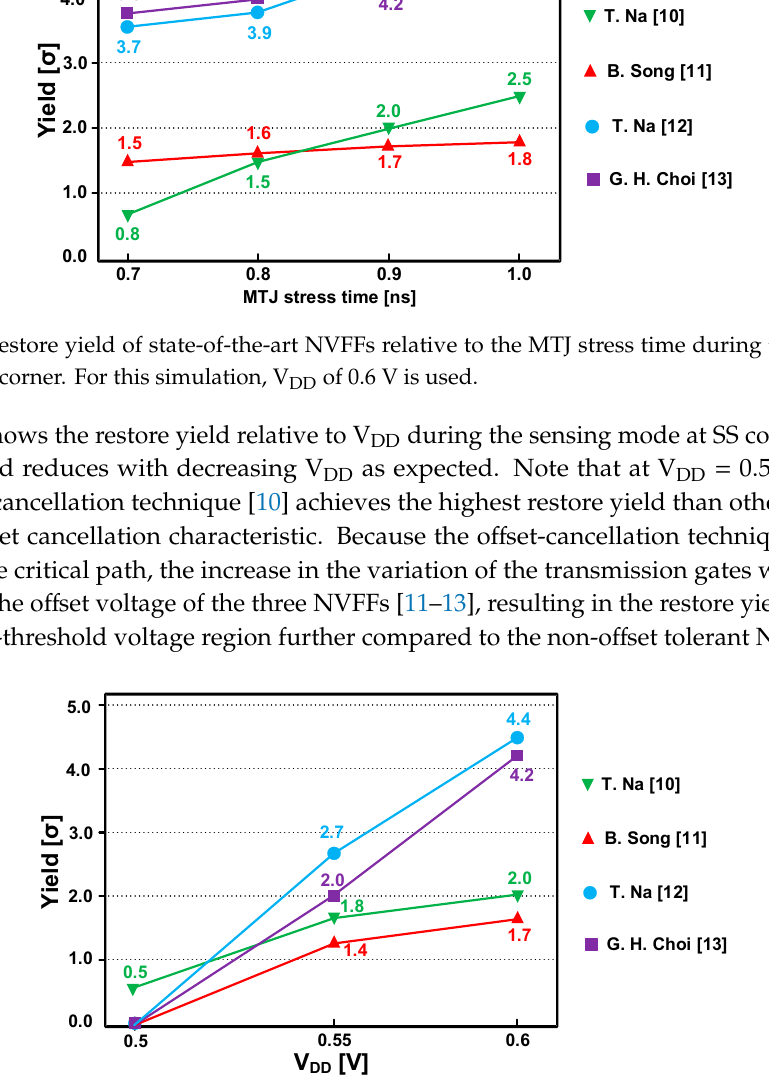
Figure 7. Restore yield of state-of-the-art NVFFs relative to V DD during the sensing mode at SS corner. For this simulation, the MTJ stress time was fixed to 0.9 ns.